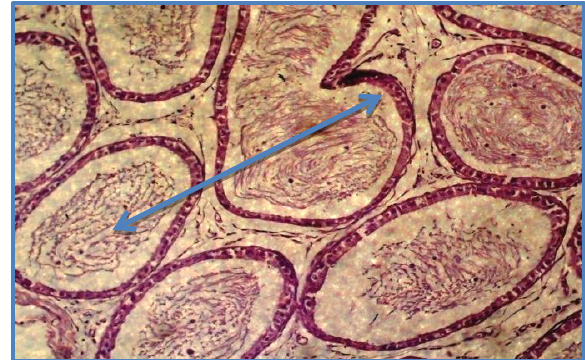
Figure, 10: Cross section of rat epididymis of group T3 showing the lumen filled with sperms (H and E stain